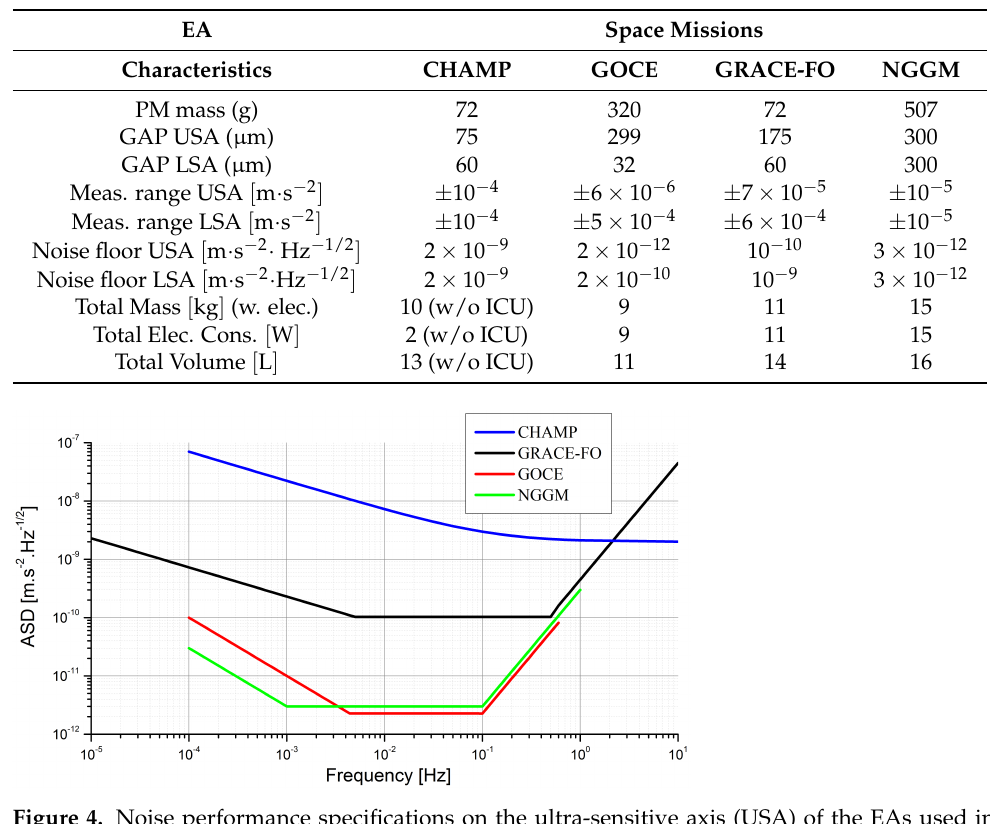
Figure 4. Noise performance specifications on the ultra-sensitive axis (USA) of the EAs used in CHAMP, GRACE-FO, GOCE, and foreseen for